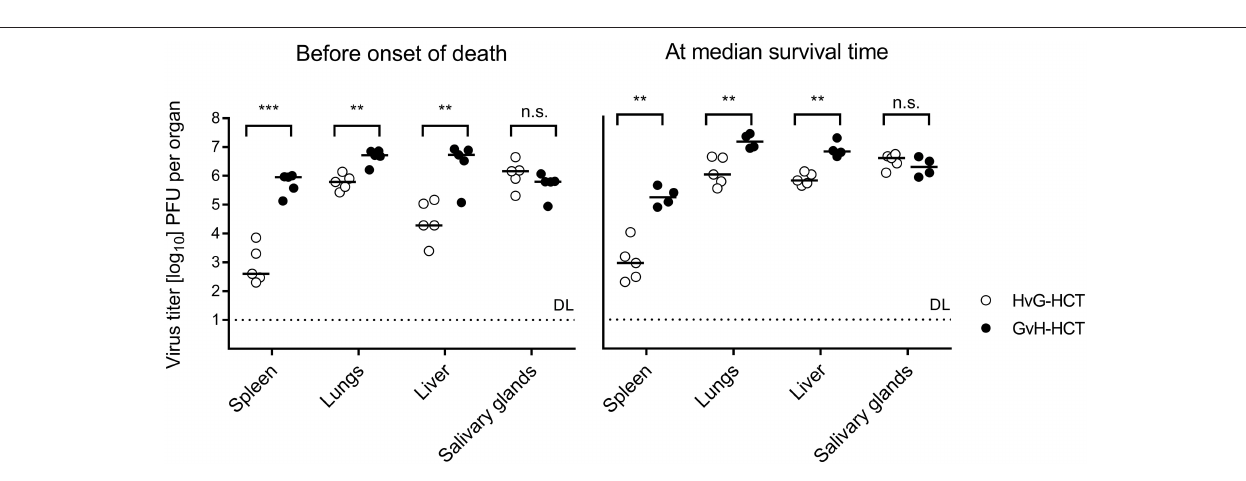
FIGURE 3 | Control of organ infection is diminished in GvH-HCT compared to HvG-HCT. Titers of infectious virus were determined for the indicated organs. (Left panel) Virus replication on day 17, that is shortly before cases of death occur after GvH-HCT. (Right panel) Virus replication on day 21, that is at the median survival time after GvH-HCT (recall Figure 1B ). Note that absolute virus titers at the median survival time may be biased by the inherent selection of mice that have survived until day 21. Symbols represent mice analyzed individually. Median values are marked. DL, detection limit of the assay. Differences between two experimental groups were determined by Student’s t -test based on log-transformed data. Significance levels: P -values of < 0.01 (**), and < 0.001 (***). n.s., not